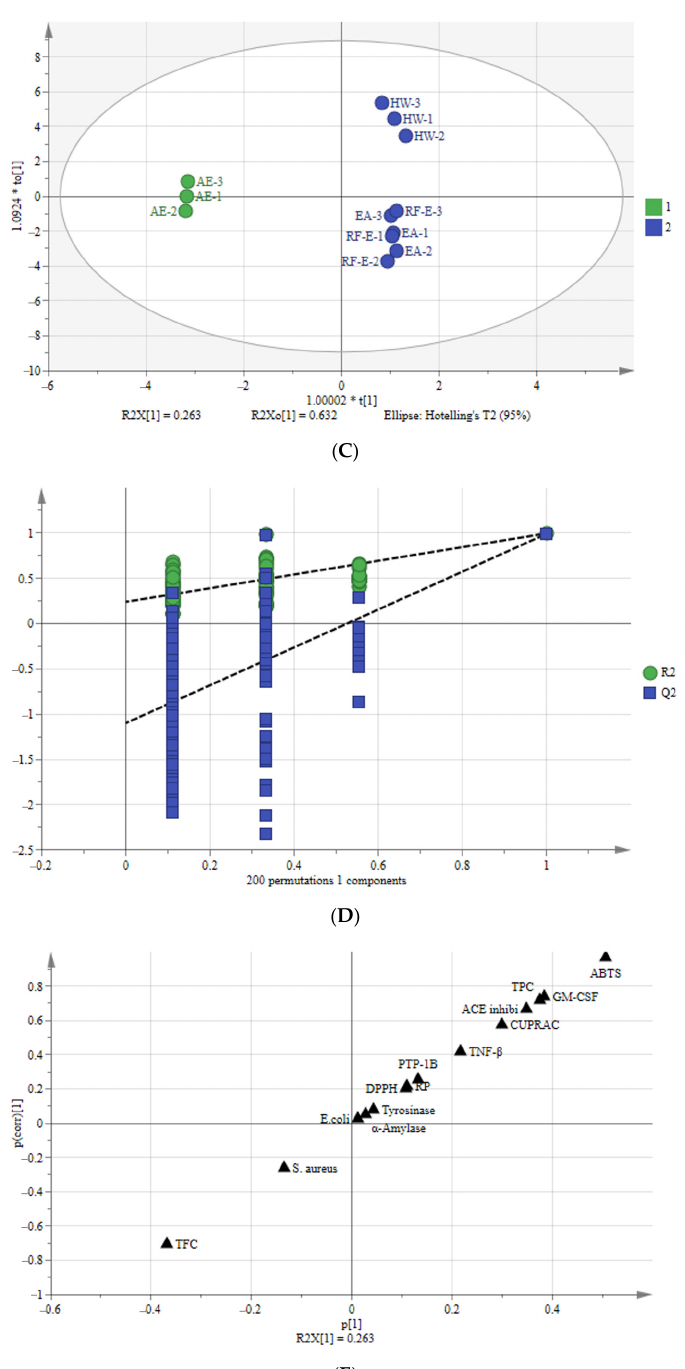
Figure 5. Multivariate analysis of A. trifoliata flower extracts. ( A ) PCA score plot, R 2 X = 99.6%, Q 2 = 96.3%. ( B ) Heatmap analysis. ( C ) OPLS-DA plot, R 2 X = 96.2%, R 2 Y = 99.6%, Q 2 = 99.1%. ( D ) Permutation plot of OPLS-DA, with intercepts of R 2 and Q 2 being 0.24 and –1.1, respectively. ( E ) S-plots associated with OPLS-DA scores of Class 1 and 2 members. See Figure 1 for